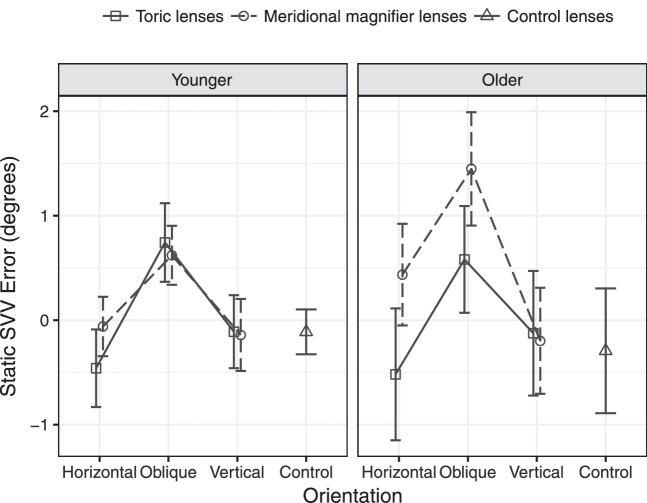
Static SVV errors as a function of age group, lens type, and orientation. Error bars represent SEM.